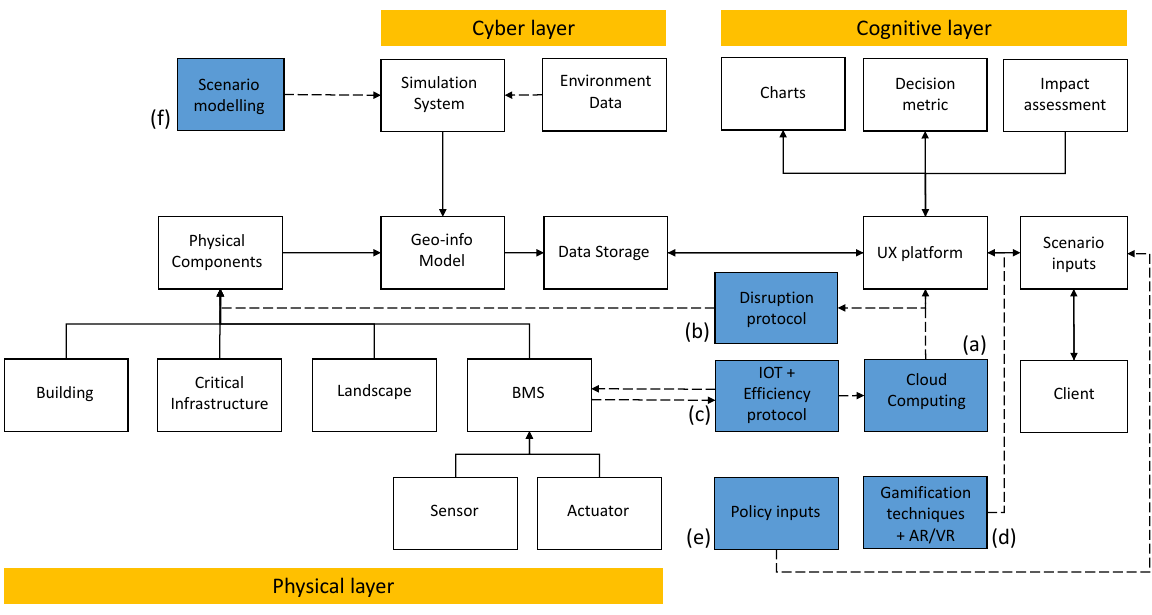
Figure 1. Conceptual architecture for developing an Urban Digital Twin. Note: BMS–Building Management System, IOT–Internet of things, VR–Virtual Reality, AR–Augmented Reality. Blue colored boxes indicate technologies specific to six UDT use case groups as listed in Table